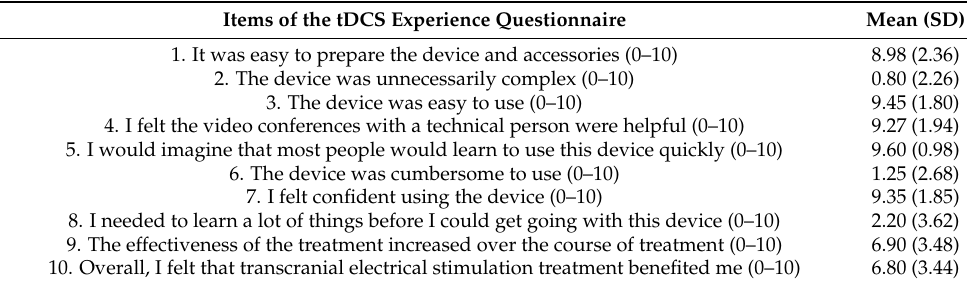
Figure 3. Mobilization Observation Behaviour Intensity Dementia (MOBID) scores over time of the active and the sham tDCS groups ( n = 40). The dashed red line represents the mean MOBID scores of the active tDCS group, and the solid green line represents the mean MOBID score of the sham tDCS group. Table 5. Descriptive results for the tDCS experience questionnaire ( n =